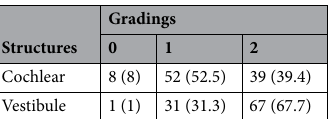
Table 3. The numbers of ears in different cochlear and vestibular scores (n = 99 ears, n (%)).